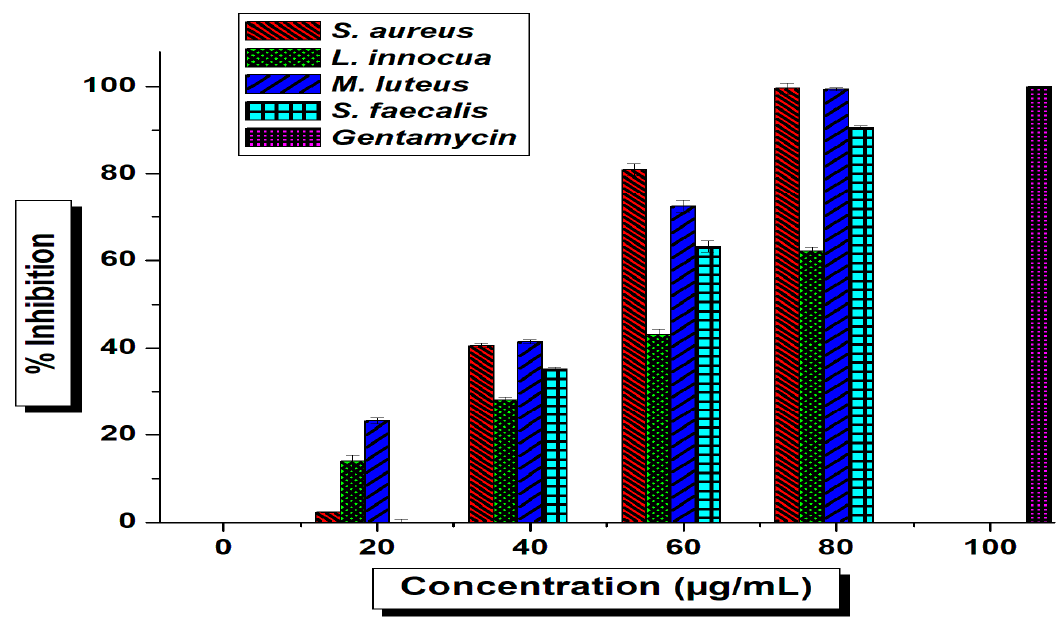
Figure 6. Determination of MICs of T. funiculosus –AgNPs against foodborne pathogens using microbroth dilution; standard deviation is shown. Significant difference ( p ≤ 0.05).